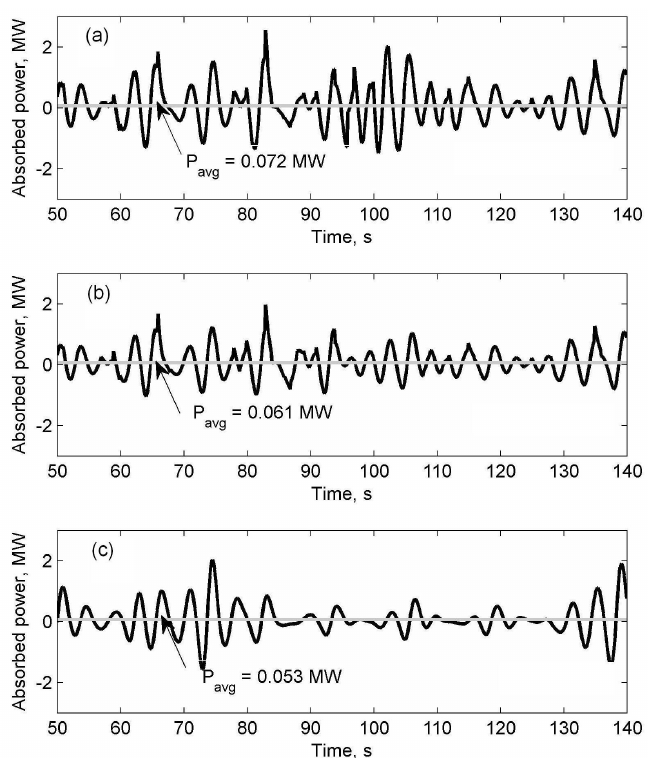
Figure 5. The instantaneous absorbed power (black) along with the corresponding time- averaged power (grey) ( a ) PSO-FLC; ( b ) FS-FLC; ( c )